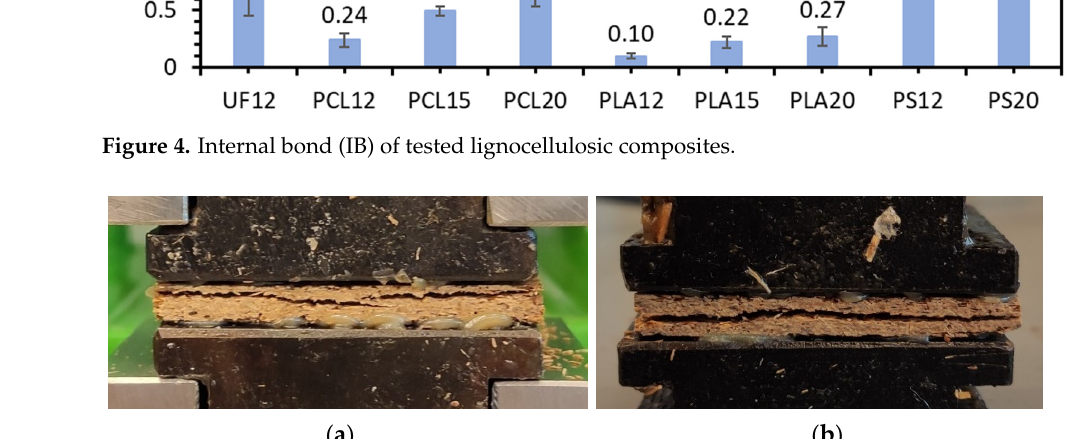
Figure 5. Two representative forms of damage after the IB test ( a ) near-surface zone ( b ) in the core layer.